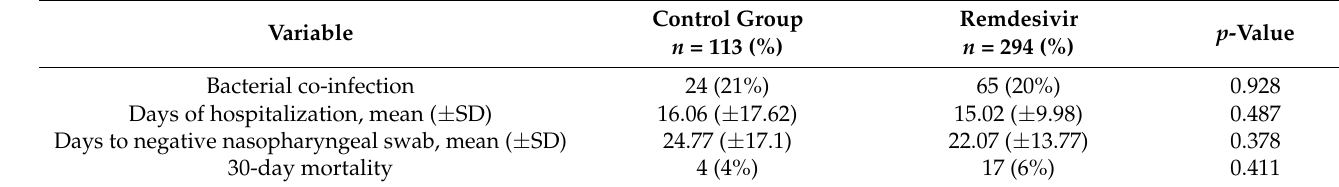
Table 3. Outcomes of COVID-19 patients treated with remdesivir or not.